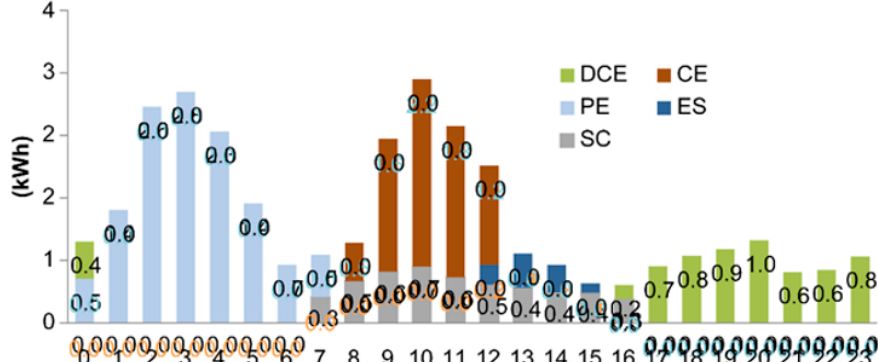
Figure 11. Hourly energy balance for PV8 SB (L) in February 2020.